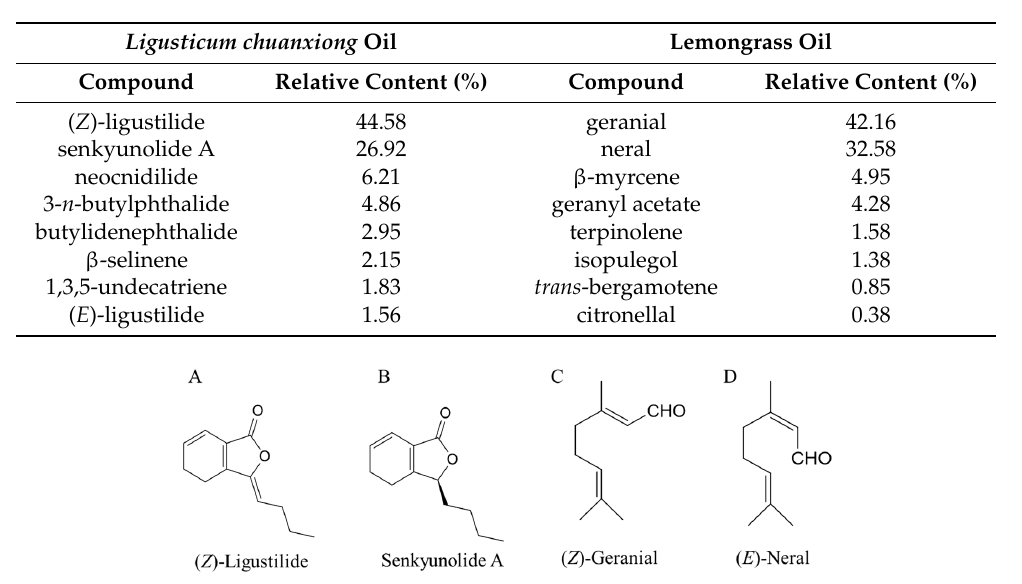
Figure 1. Structures of ( Z )-ligustilide and senkyunolide A from Ligusticum chuanxiong oil, and ( Z )-Geranial and ( E )-Neral from lemongrass oil.